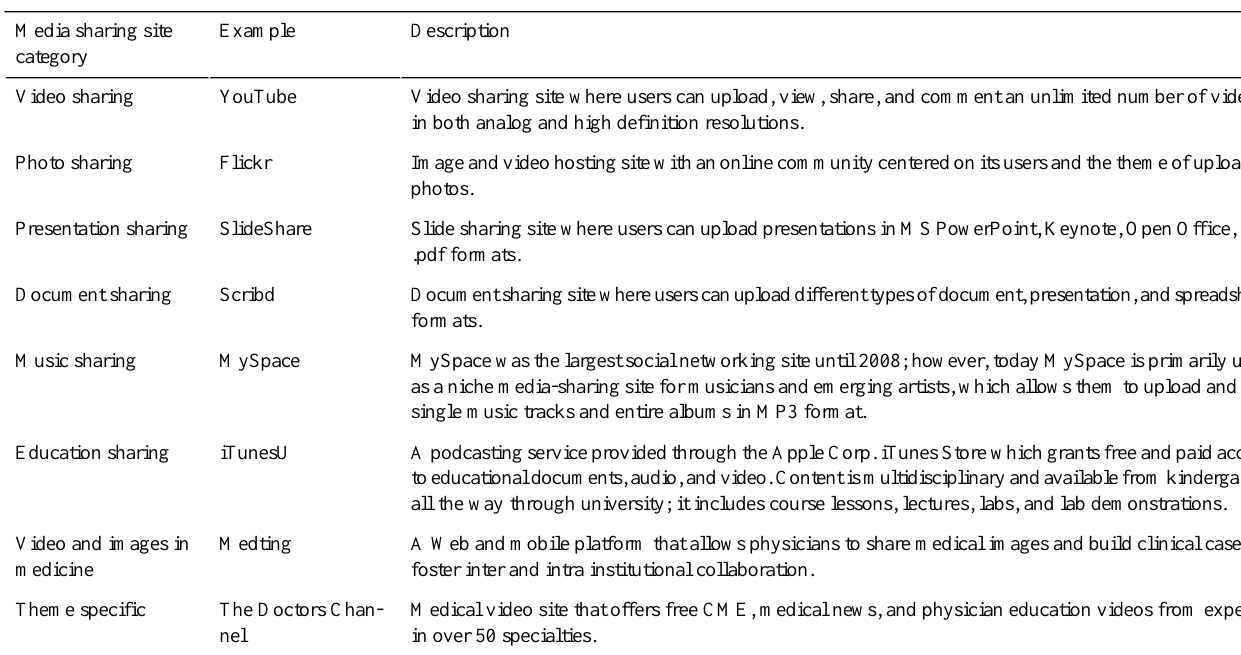
Table 3. Types and descriptions of different media sharing sites. DescriptionExampleMedia sharing